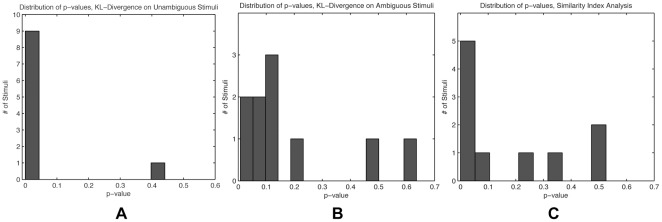
Bootstrapping Distributions.Shown are the distributions of p-values for (a) KL-Divergence on the unambiguous stimuli, (b) KL-Divergence on Ambiguous Stimuli with different percepts, (c) the similarity index δ. All of them are nonuniform and right-skewed.